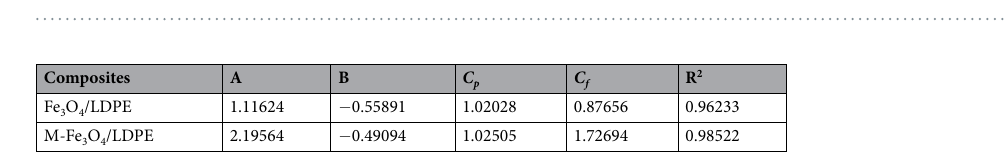
Figure 4. Thermal conductivity of the Fe 3 O 4 /LDPE and M-Fe 3 O 4 /LDPE composites based on experimental data and Maxwell-Eucken’s model.